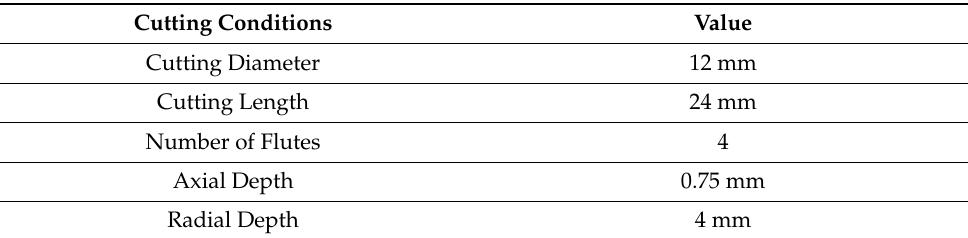
Table 3. Constant cutting conditions applied during the whole